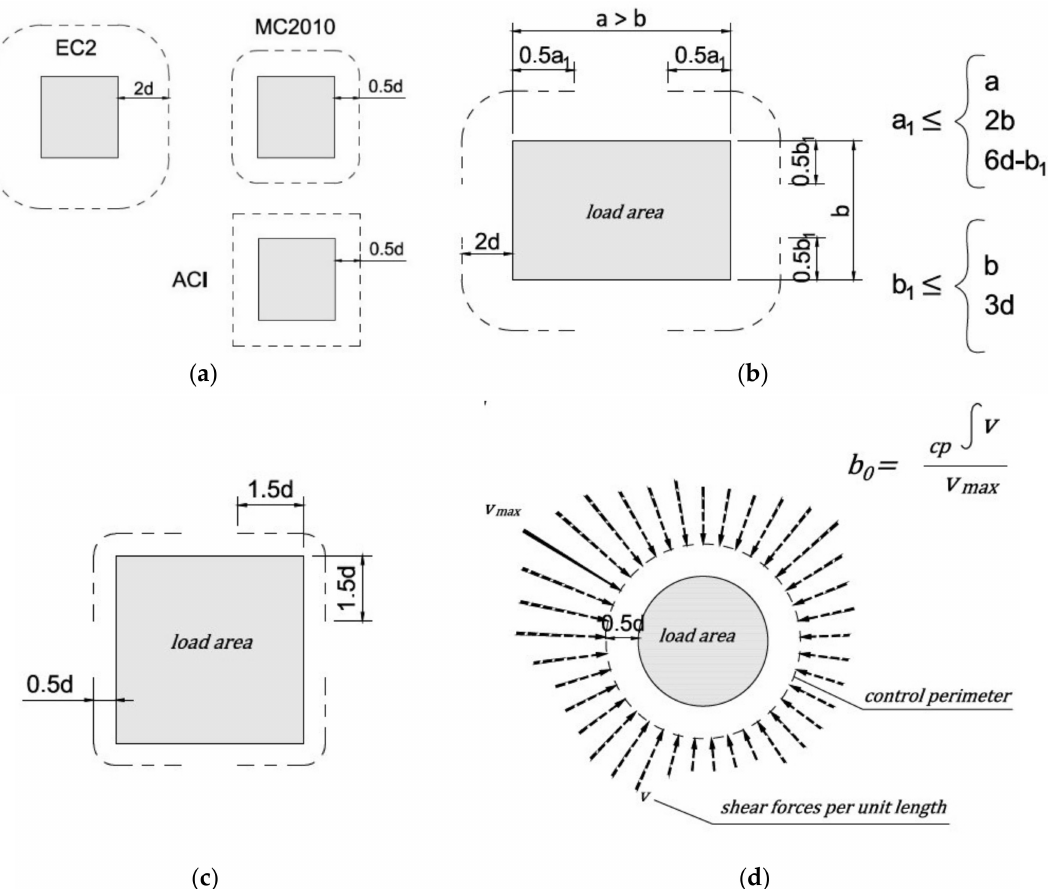
Figure 3. Control perimeter for punching shear according to different design methods: ( a ) basic control perimeter of ACI, EC2, MC2010; ( b ) reduction of control perimeter according to EC2-DIN; ( c ) reduction of control perimeter according to the MC2010-simplified method; ( d ) reduction of control perimeter according to the MC2010-general